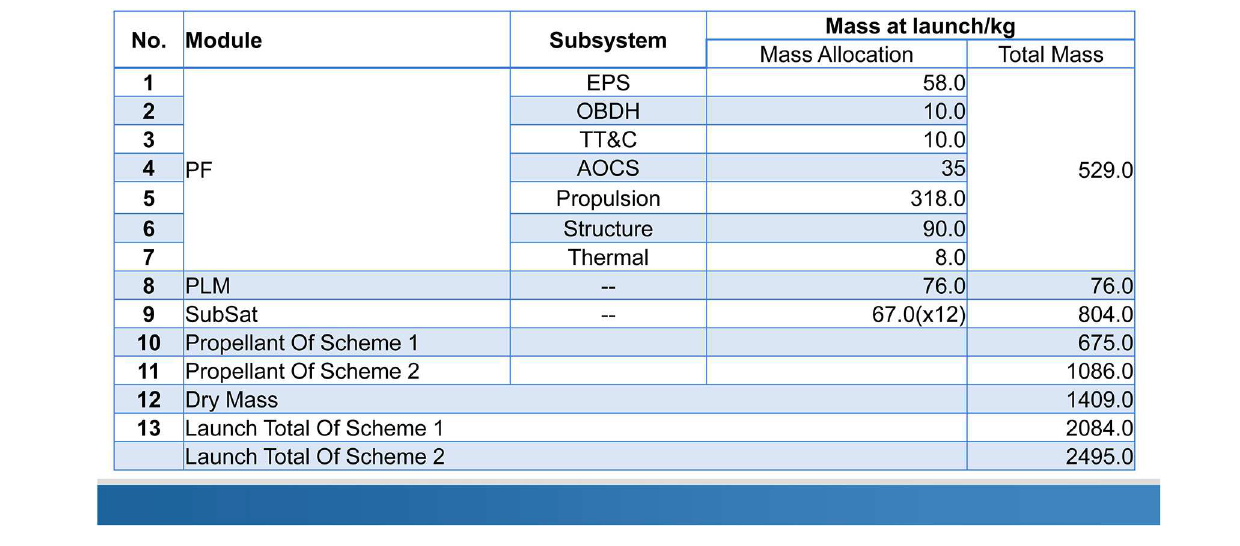
FIGURE 12 | The mass budget of the AME